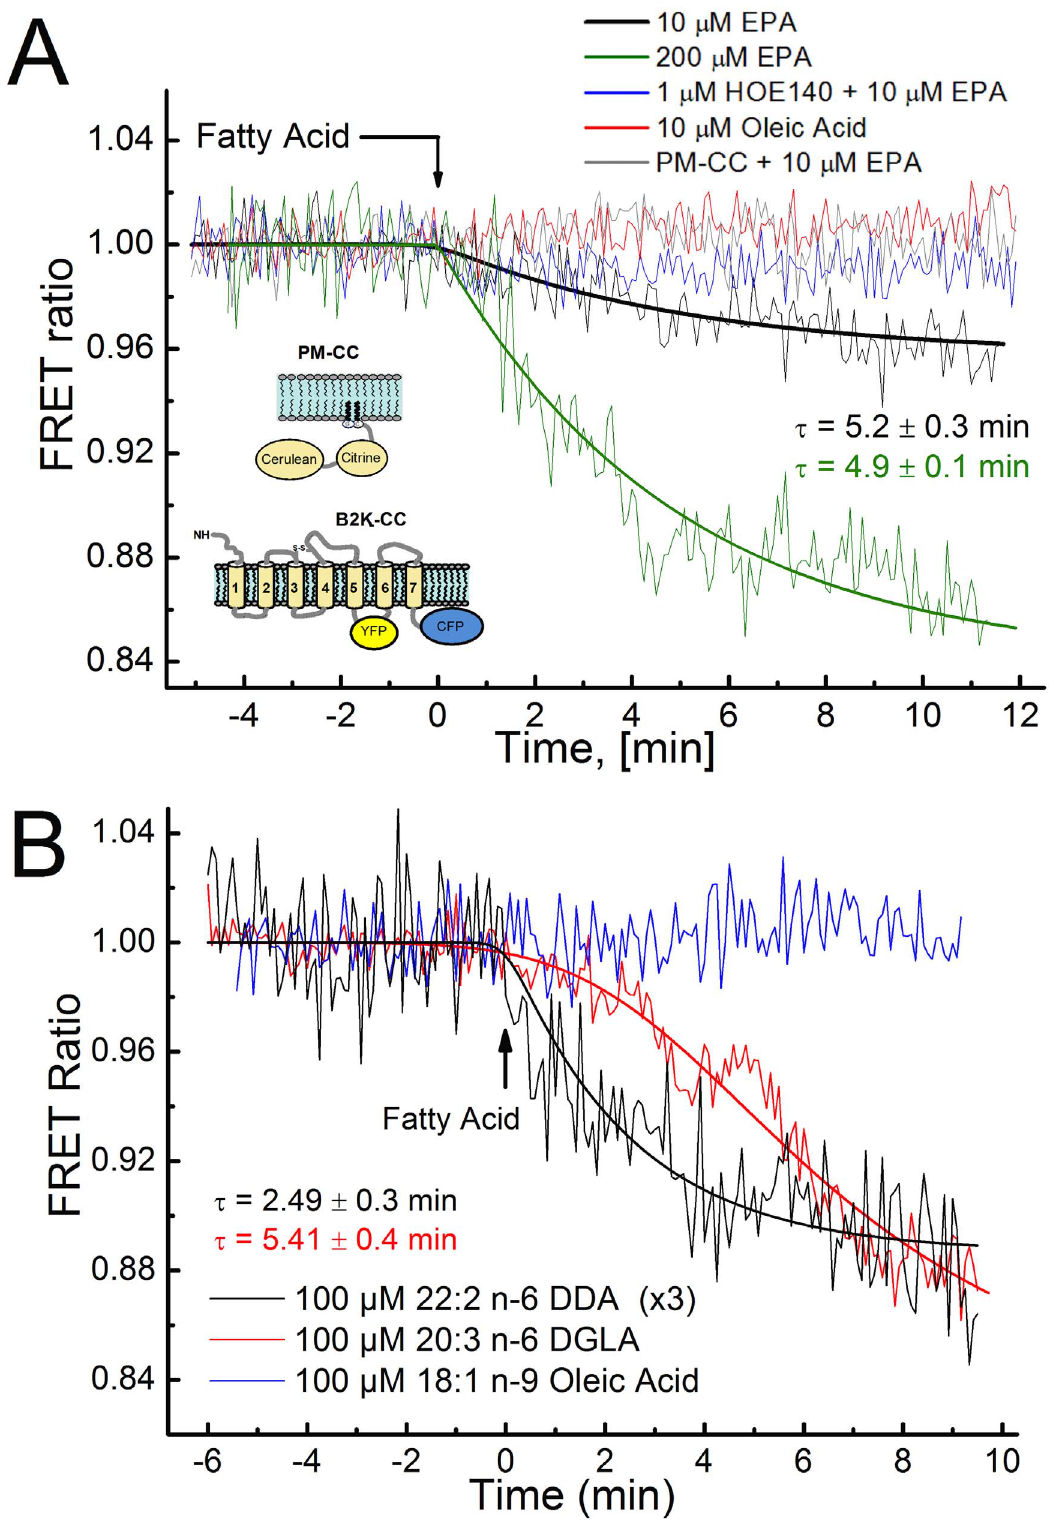
Figure 1. Response of B2K-CC FRET sensor and PM-CC (control FRET sensor) to stimulation by polyunsaturated fatty acids. B2K-CC transfected HEK-293 cells treated with (A) EPA, EPA and B 2 R inhibitor (HOE-140), oleic acid or (B) DDA, DGLA. Experiments were performed 24 h after transfection of B2K-CC FRET sensor or PM-CC in HEK293 cells on chambered cover glass at 37 u C. FRET ratio was defined as ratio of Citrine emission intensity at 525 nm to Cerulean emission intensity at 475 nm.